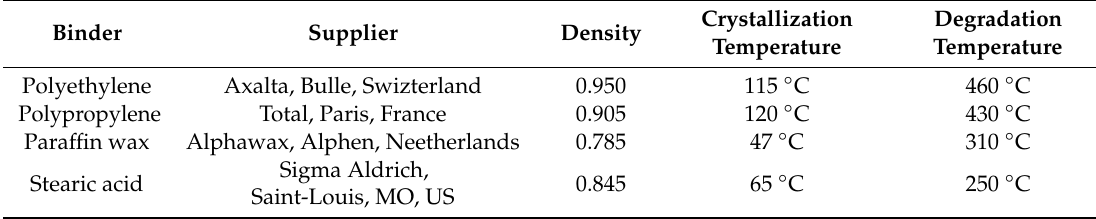
Table 1. Characteristics of binder